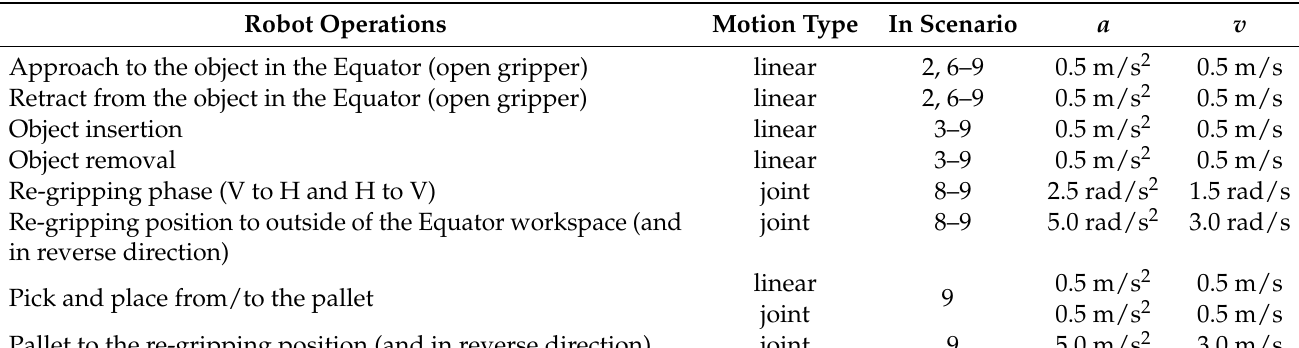
Table 2. Short description of compound robot manipulation operations from basic functions in measurement scenarios (motion type, desired velocities v , acceletaions a , and involvement in